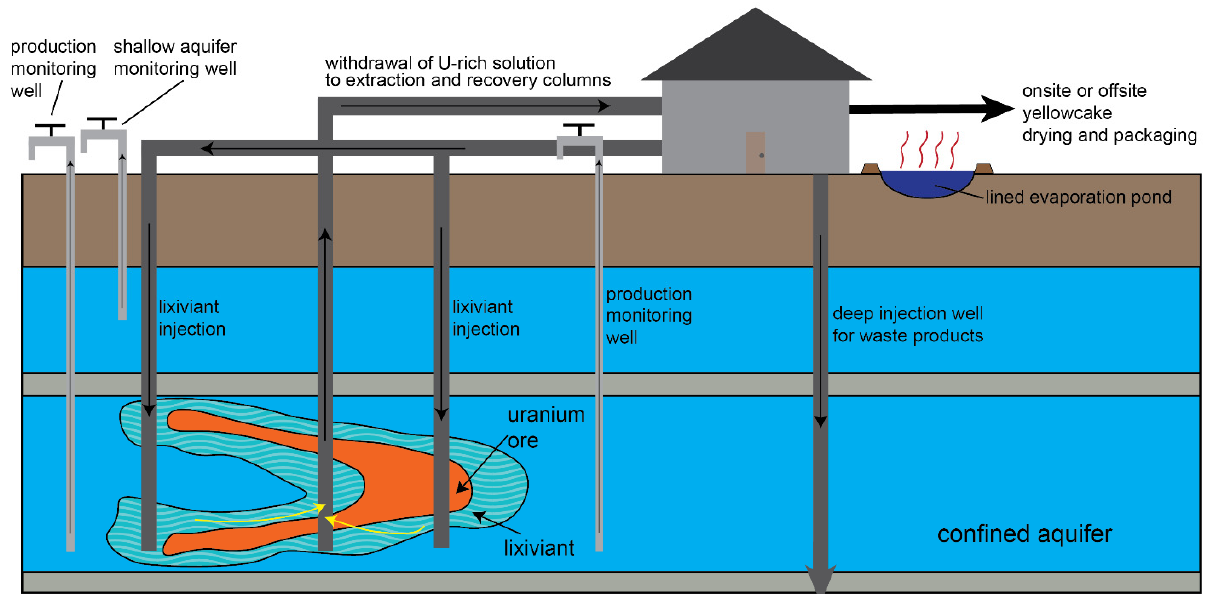
Figure 6. Cross section of basic components of in situ recovery (ISR) uranium mining operation. Modified from [82].